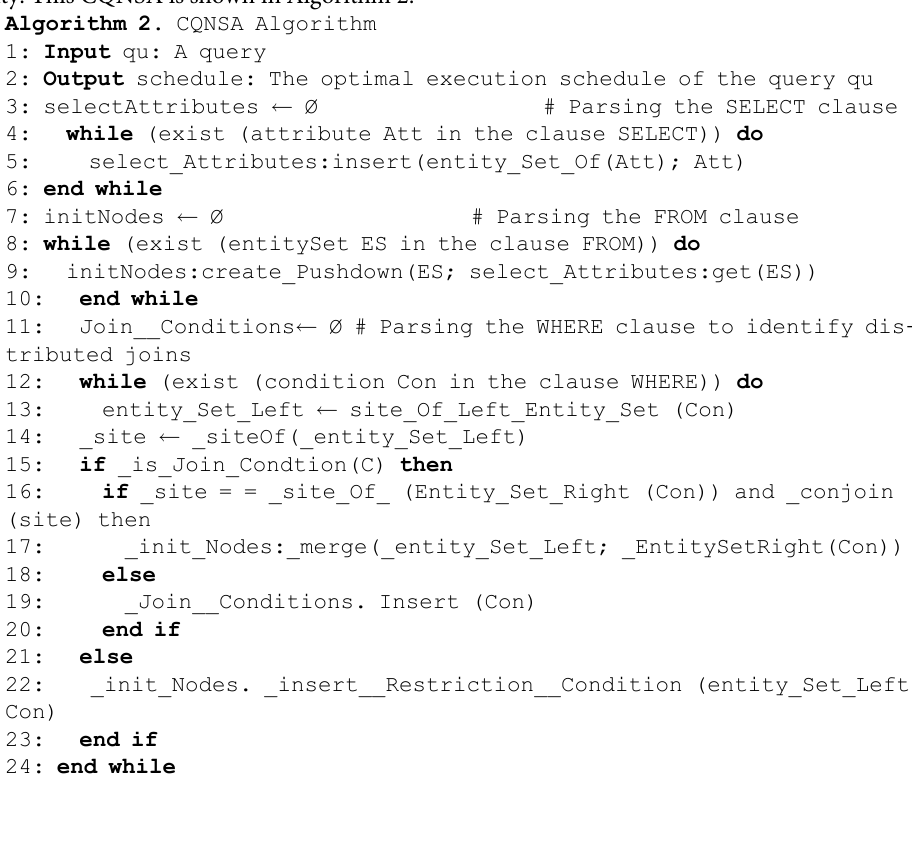
Algorithm 2 . CQNSA